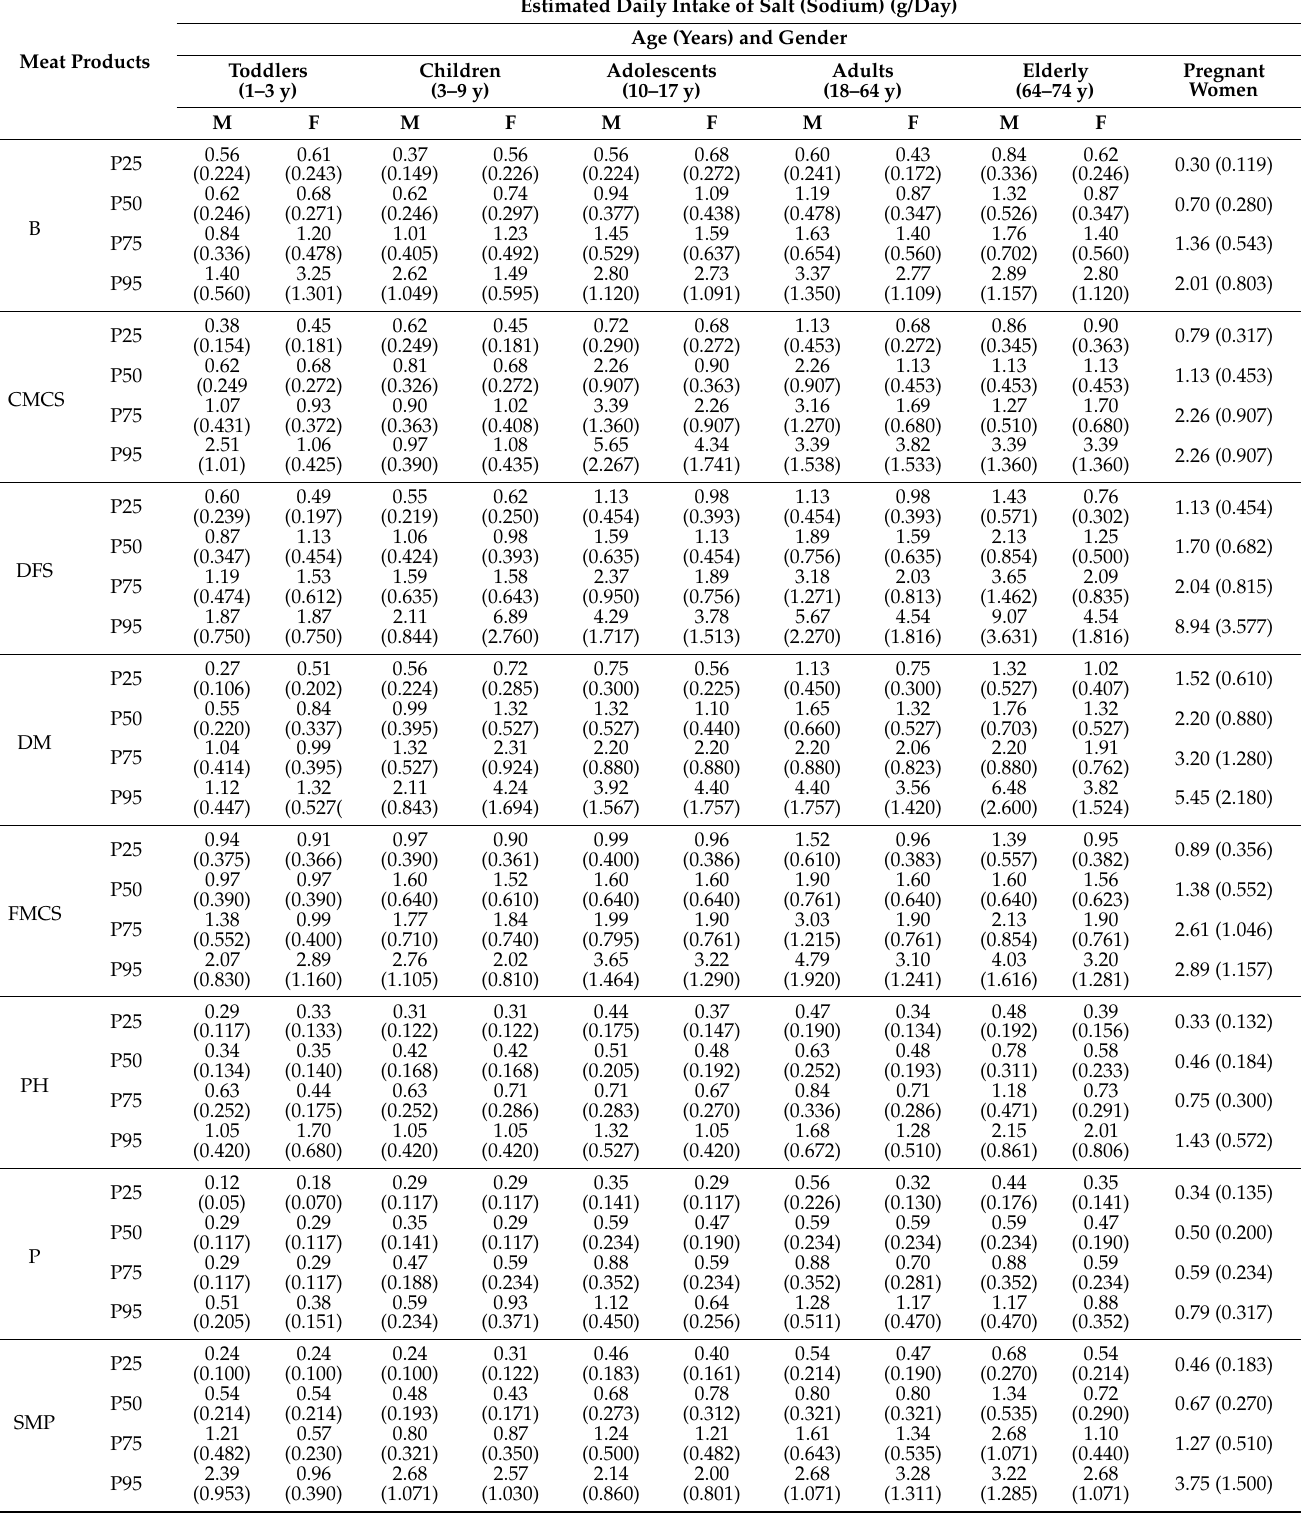
Table 3. Distribution of daily intake of salt (sodium) (g/day) through consumption of meat